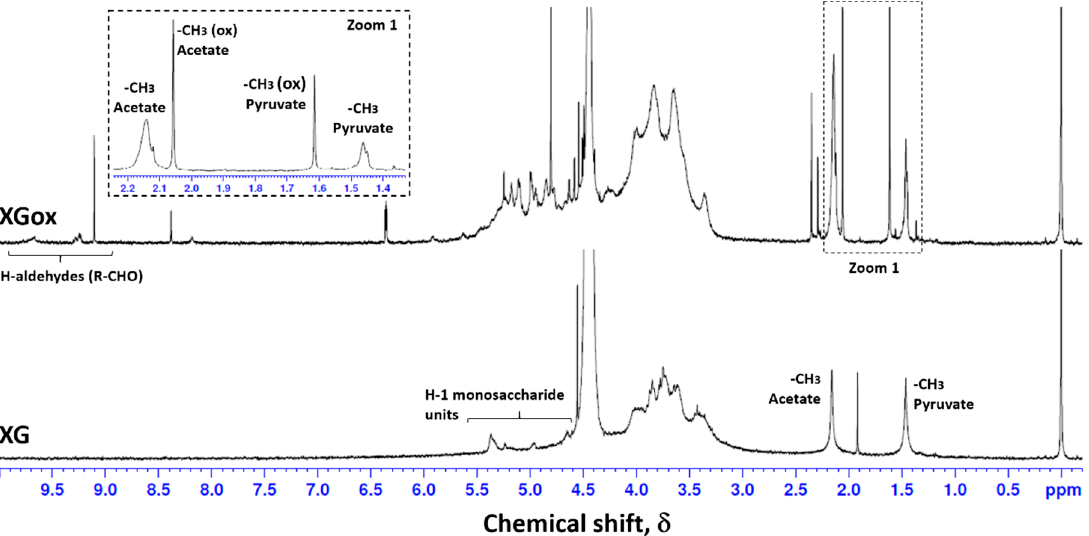
Figure 3. 1 H NMR spectra for xanthan gum (XG) and oxidized xanthan gum (XGox) obtained at 55 °C.